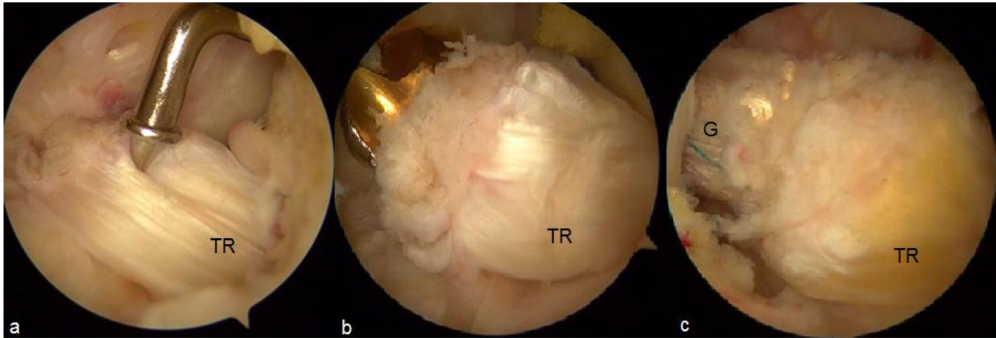
Figure 1. Reconstruction with preservation of the distal anterior cruciate ligament (ACL) remnant: ( a ) Tibial guide placed in the middle of a tibial remnant (TR); ( b ) Drilling of the tibial tunnel through the tibial remnant; ( c ) ACL graft (G) passing through the distal remnant of a native